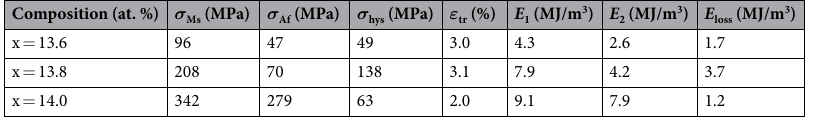
Table 2. The critical transformation stresses σ Ms and σ Af , stress hysteresis σ hys = ( σ Ms − σ Af ), transformation strain ε tr , total work done on the specimen E 1 , energy density per unit volume which is stored and available upon unloading E